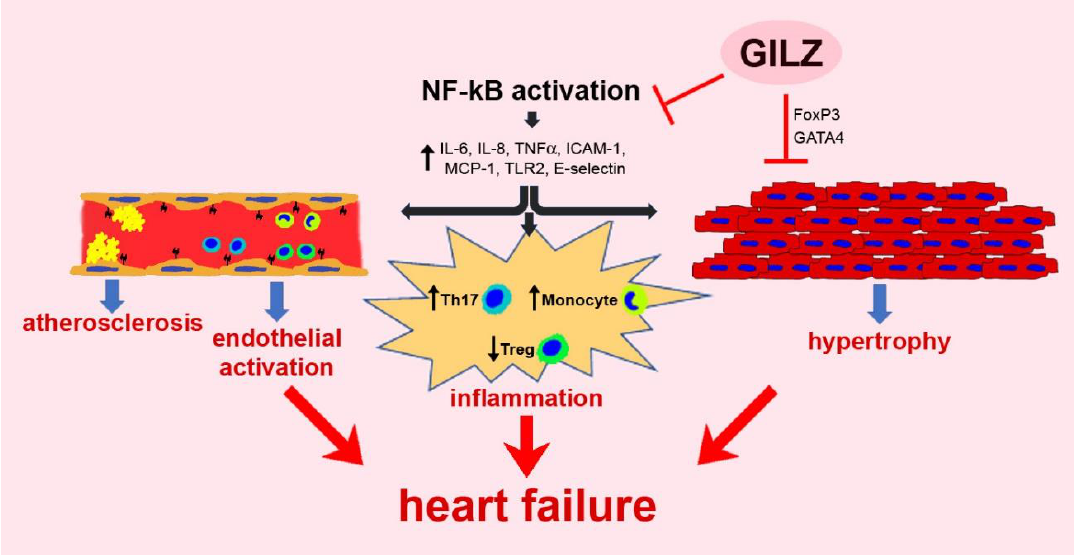
Figure 1. A schematic representation of GILZ participation in pathologic processes regarding the myocardium and the vascular system.